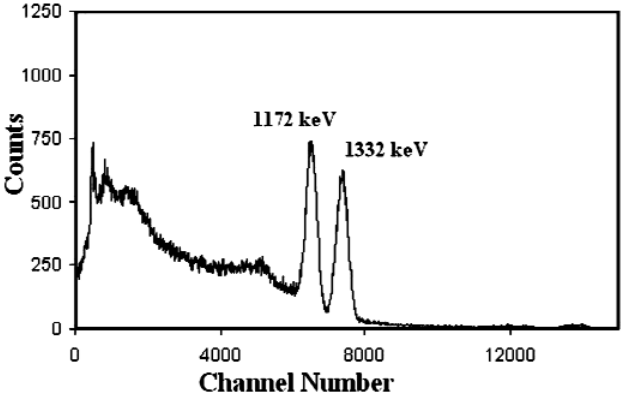
Figure3. Gamma ray spectrum obtained from 60 Co